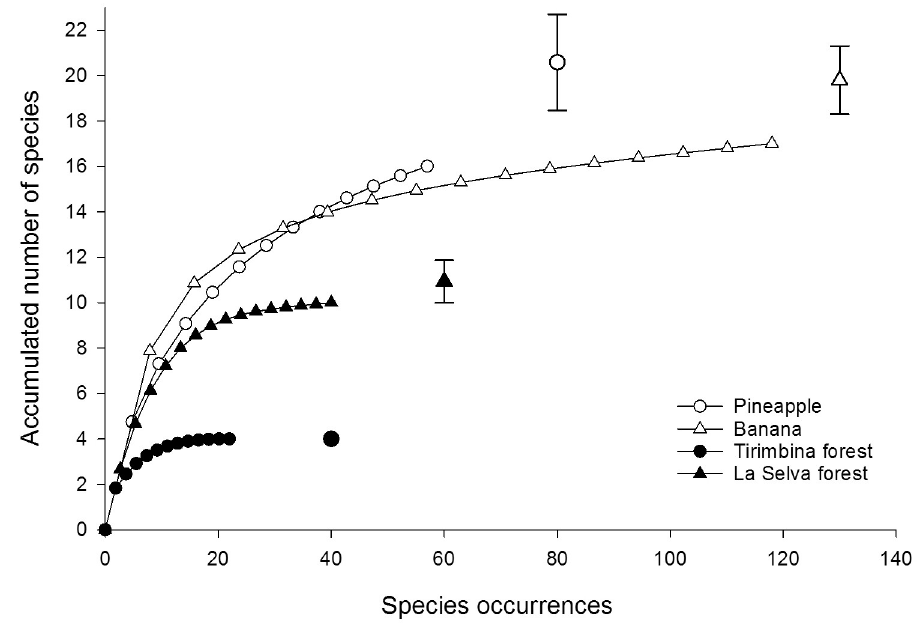
Fig 2. Accumulated number of species occurrences in plantation and forest habitat based on acoustic monitoring within the two focal areas in Sarapiquı´, Costa Rica. Separate points stand for the expected number of species (with standard deviation) calculated using the ICE species richness estimator.